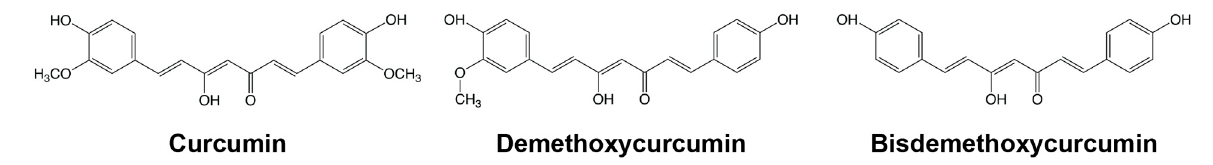
Figure 1. Chemical structures of turmeric-derived curcuminoids, of which curcumin is the most abundant.